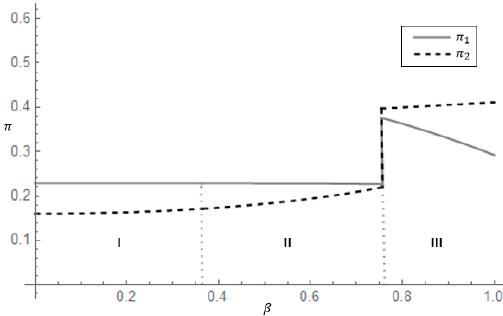
β β on retailers’ profits. on retailers’ profits.